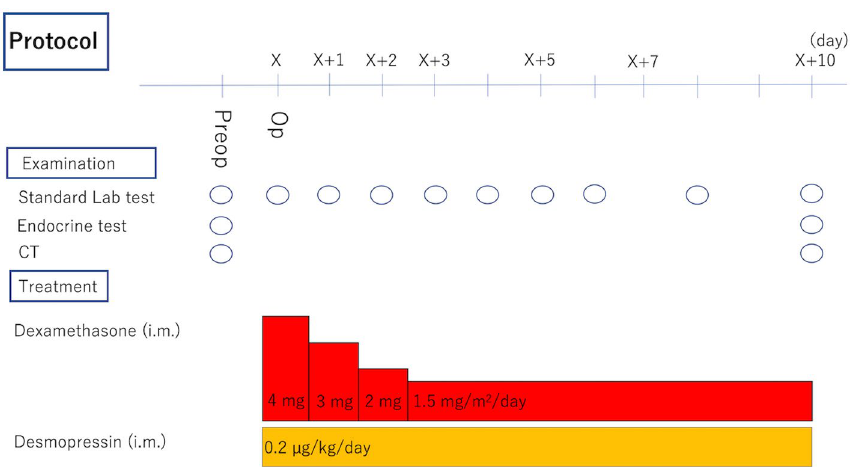
Figure 3. Protocol of perioperative management. Preop preoperatively, Op operatively, Lab laboratory, i.m.